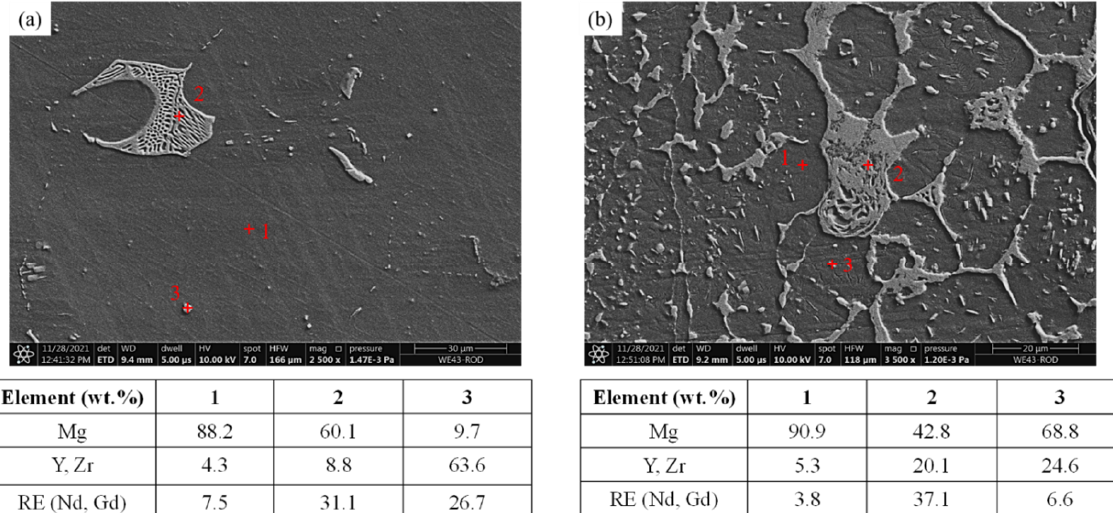
Figure 7. Energy-dispersive spectroscopy (EDS) spot analysis for the ( a ) core, and ( b ) edge for the α-Mg matrix, eutectic phase, and cuboid-shaped precipitate.